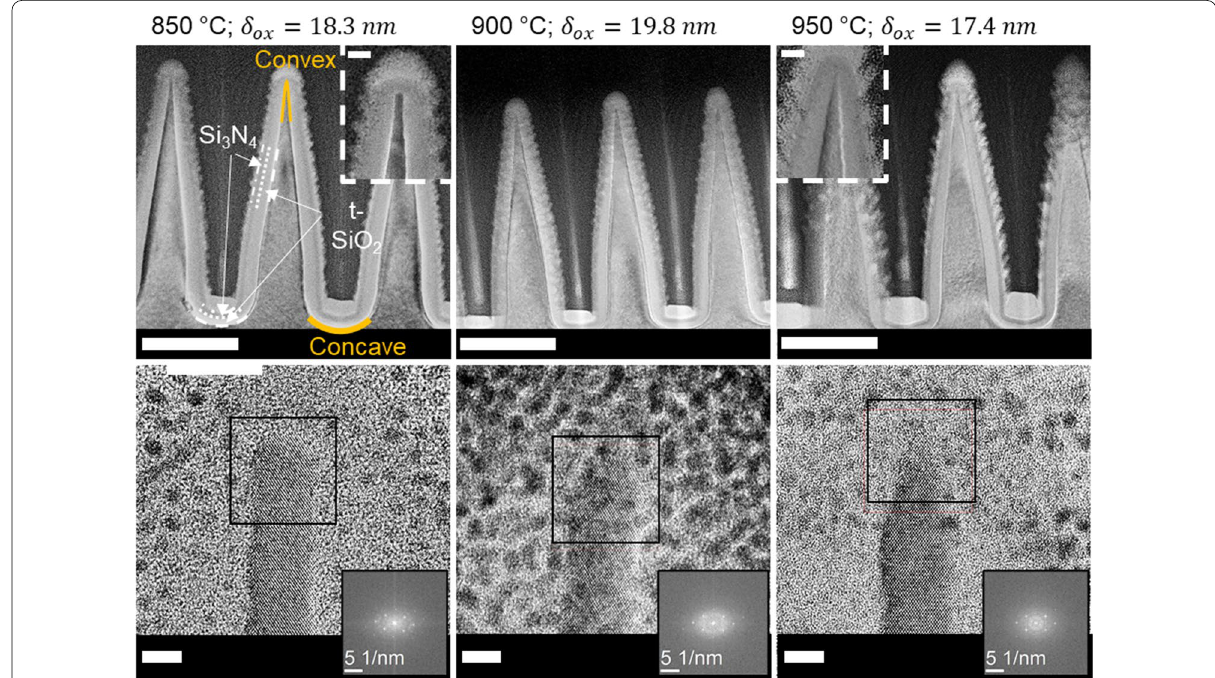
Fig. 4 TEM images were recorded for different oxidation temperatures in the corresponding columns. The scale bars in the top-row images represent 200 nm. The insets in the top row show a magnification of the center tip with scale bars representing 20 nm. The bottom row shows a larger magnification of the same center tips as displayed in the top-row figures, whereas the scale bars represent 5 nm. The bottom-row insets display a windowed fast Fourier transform of the lattice. Analyses of the reciprocal lattice confirm that the material is crystalline